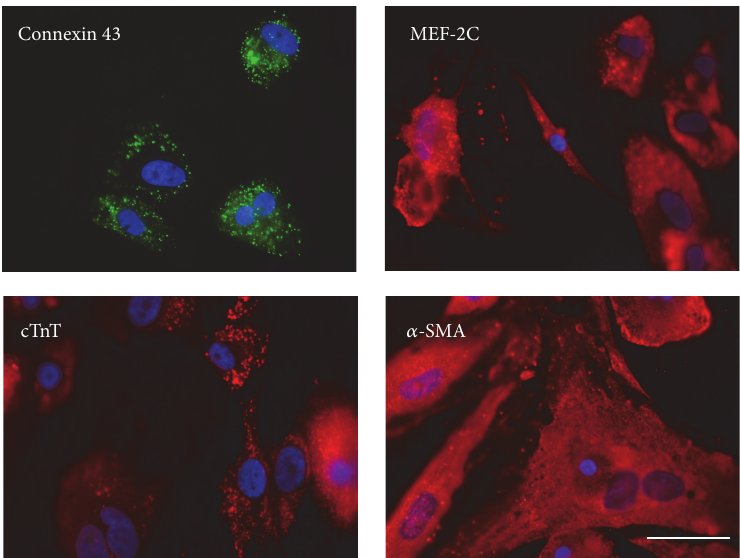
Figure 3: Multipotent capacity of myxoma derived cells. Immunostaining of subcultured myxoma derived phase-bright cells with connexin 43, myocyte enhancer factor 2C (MEF-2C), cardiac troponin T (cTnT), and 𝛼 -smooth muscle actin ( 𝛼 -SMA). Scale bar = 10 𝜇